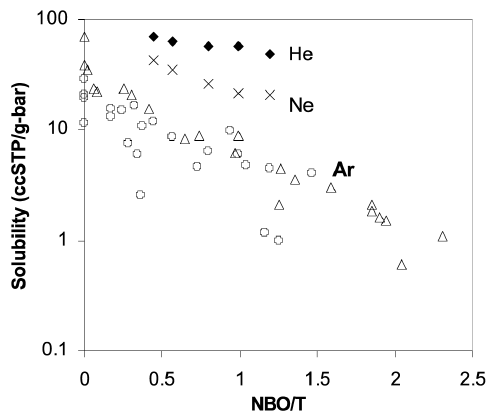
Fig. 6. Effect of melt polymerization (expressed by the NBO/T ratio, see text) on the solubility of some noble gases (modified from Shibata et al ., 1998). Da- ta for Ar are a compilation selected by Shibata et al . (1998), He and Ne from Jambon et al . (1986) and Lux (1987). Ar data are divided into two classes: T /( T +Si) ratio higher (circles) than or lower (trian- gles) than 0.1, where T is the number of tetrahedral- ly coordinated cations other than silicon ( i.e. Al, Ti). It is evident that the NBO/T ratio fails to predict the low Ar solubilities in aluminosilicate melts.